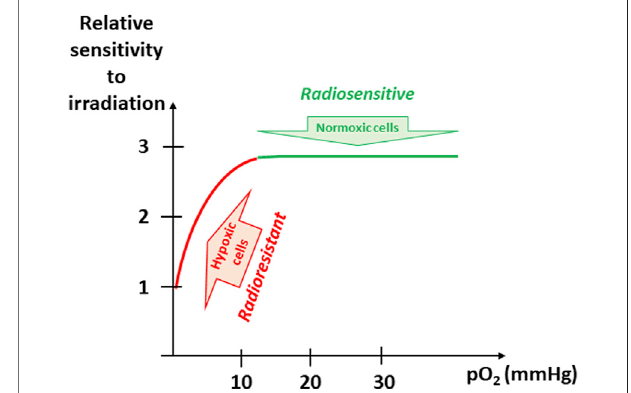
FIGURE3| EvolutionofsensitivitytoirradiationasafunctionofpO 2 .The “ oxygen enhancement ratio ” (OER, the ratio of doses required to obtain the same cell survival under hypoxic and aerobic conditions) varies from 2.5 to 3.0, indicating that hypoxic tumor cells will require a dose 2.5 – 3 times higher to be killed than normoxic cells. The OER is dramatically increasing when pO 2 is rising from 1 to 10 mmHg (found in hypoxic tumors). Above this value of 10 mmHg, further increase in pO 2 does not further enhance the